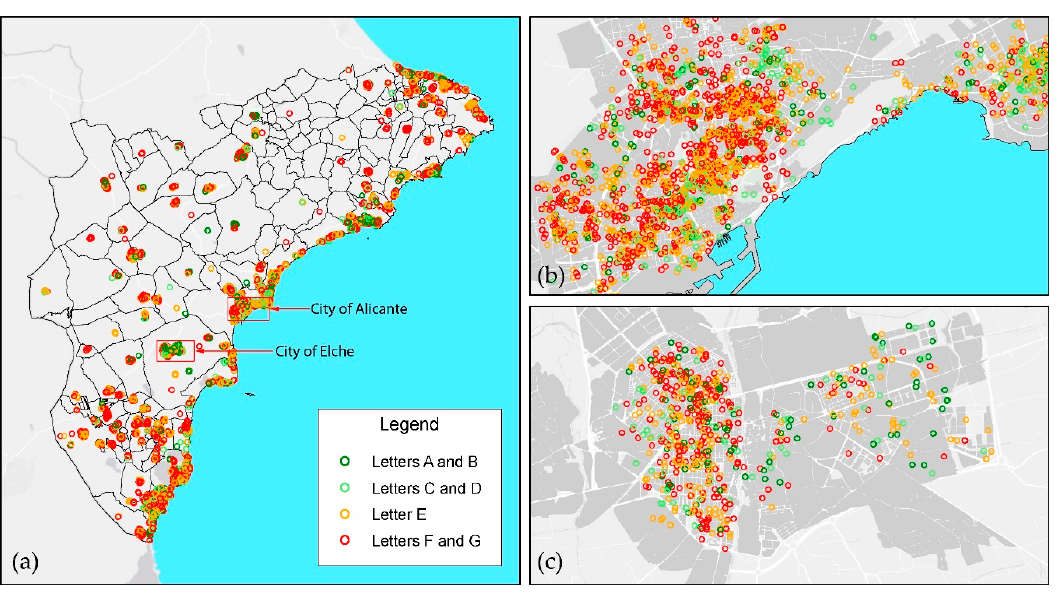
Figure 4. ( a ) Energy certificate distribution in the Alicante province; ( b ) detail of Alicante city; ( c ) detail of Elche city.